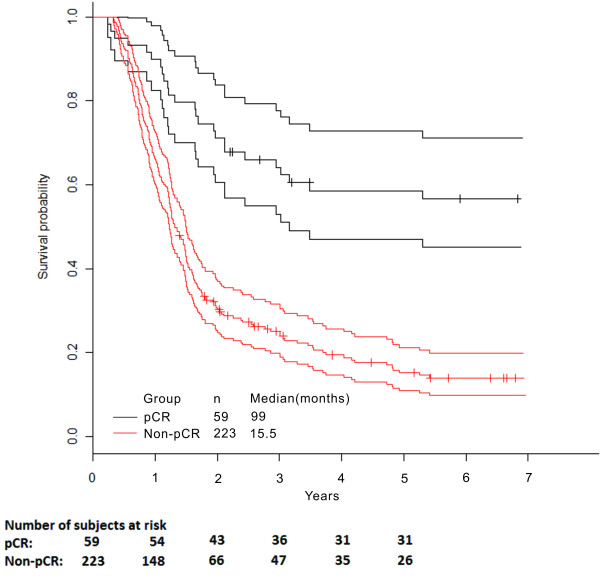
Overall survival and 95% confidence interval in patients with and without pathological complete response.